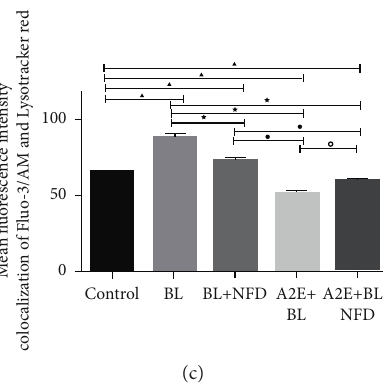
Figure 4: The level of calcium in lysosomes. (a) The green fluorescence is the intracellular Ca 2+ fluorescence labeled with Fluo-3/AM, the red fluorescence is the lysosome labeled by LysoTracker Red, and the yellow fluorescence is the Ca 2+ fluorescence in the lysosome after the two fluorescence signals are colocalized. Scale bar � 20 μ M. (b) The zoom of colocalization between Fluo-3/AM and LysoTracker Red-treated cultured RPE cells. (c) Data are presented as the mean ± SD ( n � 3). An LSD test was conducted following one-way ANOVA. Compared to the control group, ▲ P < 0 . 05; compared to the BL group, ★ P < 0 . 05; compared to the BL+NFD group, ● P < 0 . 05; and compared to the A2E group, ◇ P < 0 .